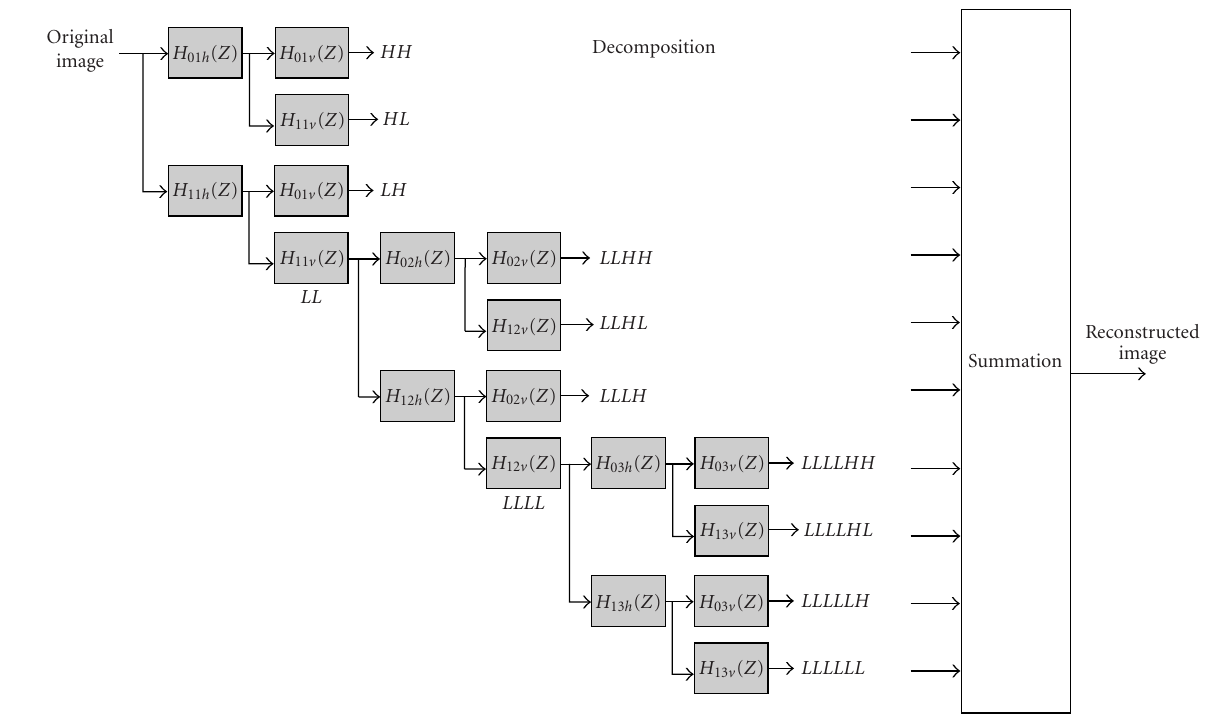
Figure 3: Filter bank used for the wavelet decomposition. H 0 mh and H 1 mh are the horizontal decomposition filters for decomposition level h and H H 0 mv and 1 mv are the vertical decomposition filters for decomposition level